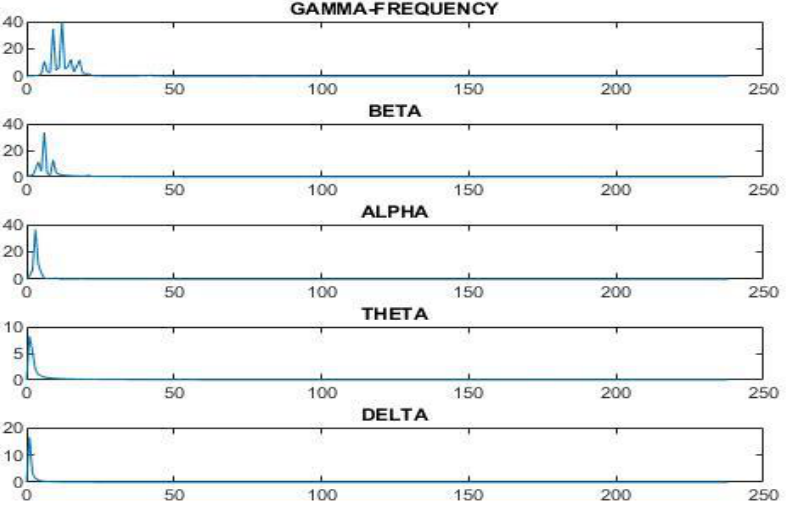
Figure 6. Frequency in EEG brain waves.